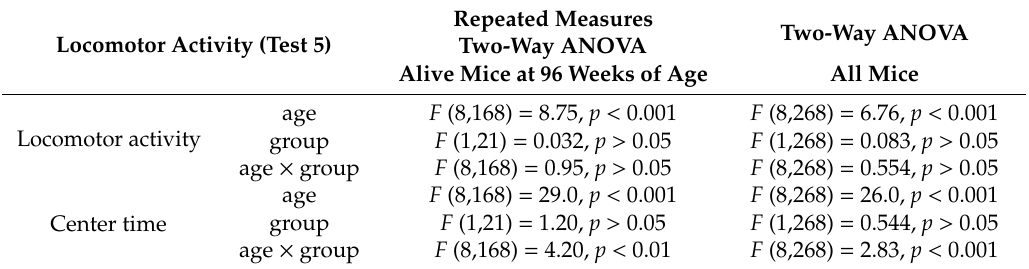
Table 3. Results of statistical analysis in Test